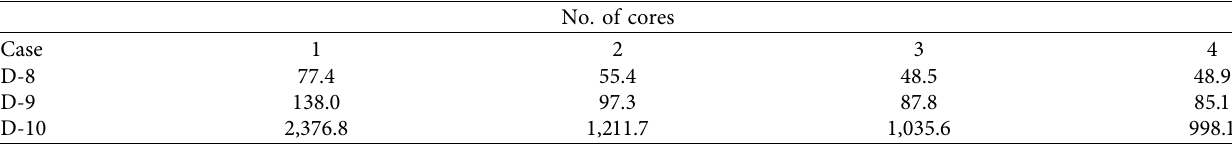
Table 5: Computational time (in seconds) to solve subproblems for simulation cases D-8, D-9 and D-10 by varying the number of computational cores of parallel computing.